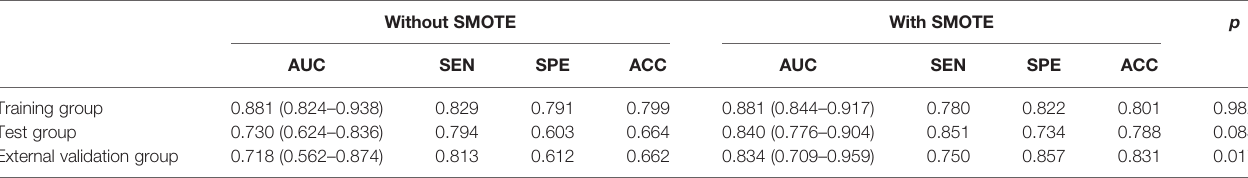
TABLE 2 | Evaluation of radiomics signature without and with SMOTE.